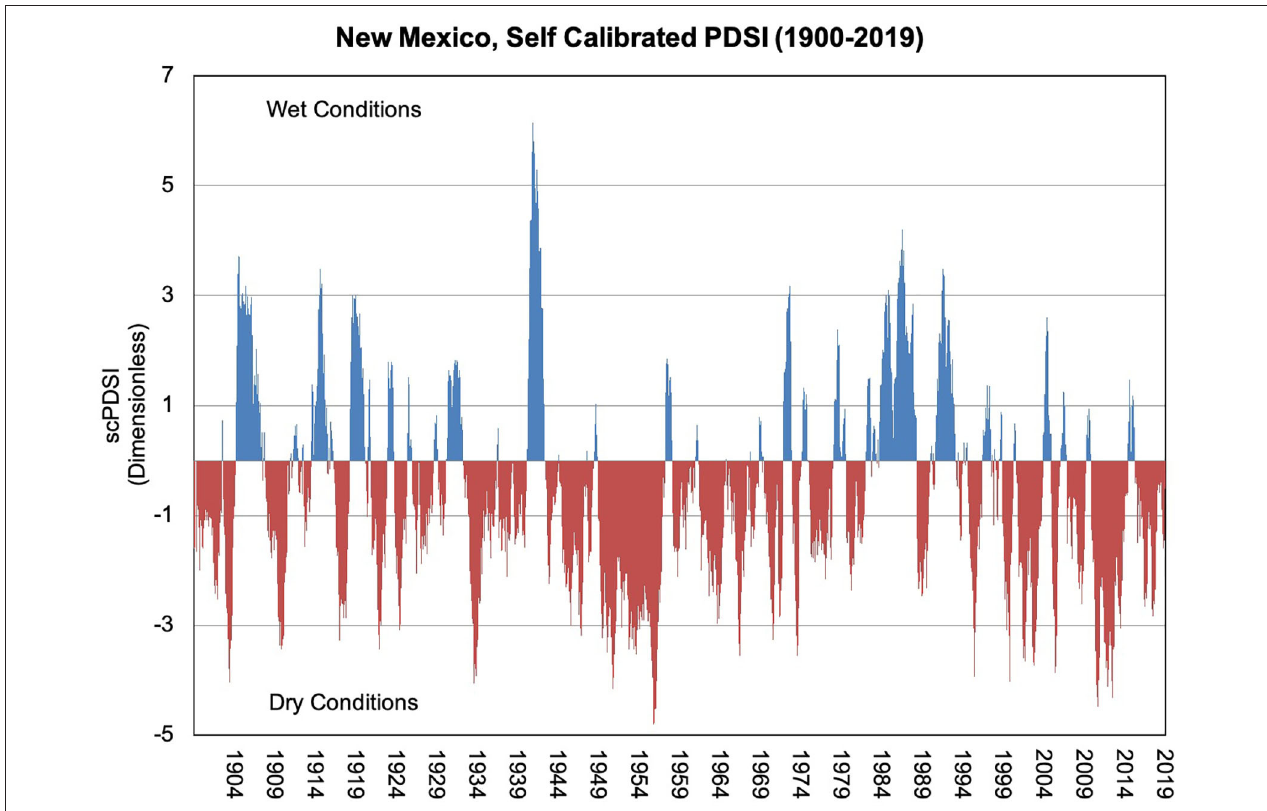
FIGURE 5 | The Self-Calibrating PDSI (sc-PDSC) for the 1900–2019 period. Positive sc-PDSI values (blue) representing wet conditions and negative sc-PDSI values (red) representing dry conditions.